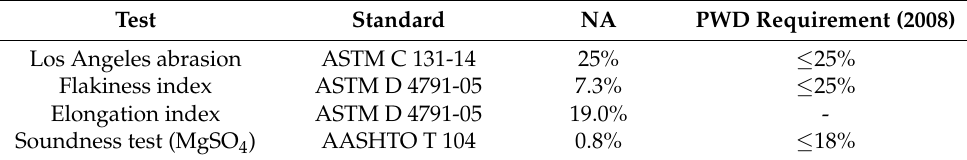
Figure 1. Primary materials used in this study to prepare ACW14 mix samples. Table 1. Basic properties of NA.